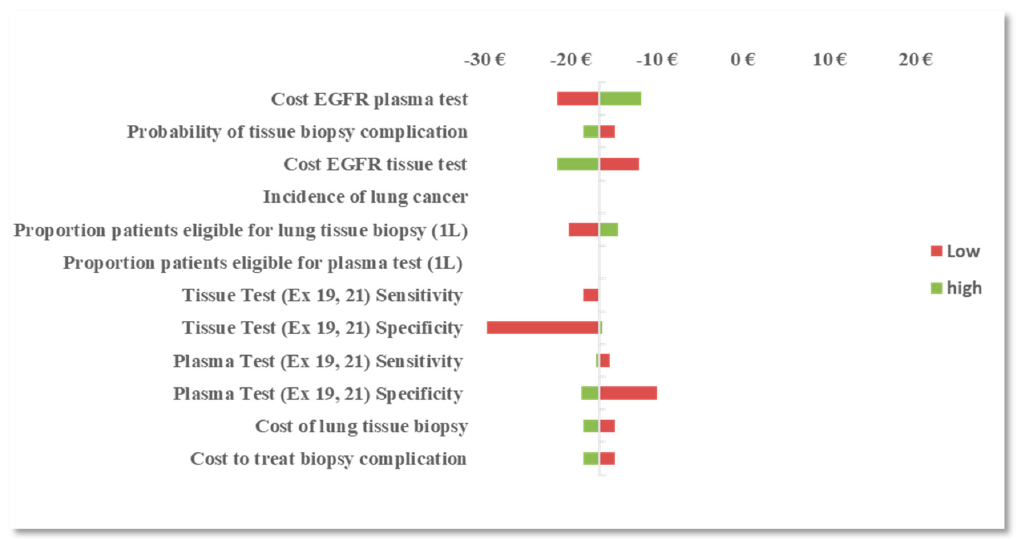
Figure 1. One-way sensitivity analysis (OWSA): difference in budget impact (BI) between the EGFR mutation combined testing approach and the tissue testing approach in the first-line (1L) setting.